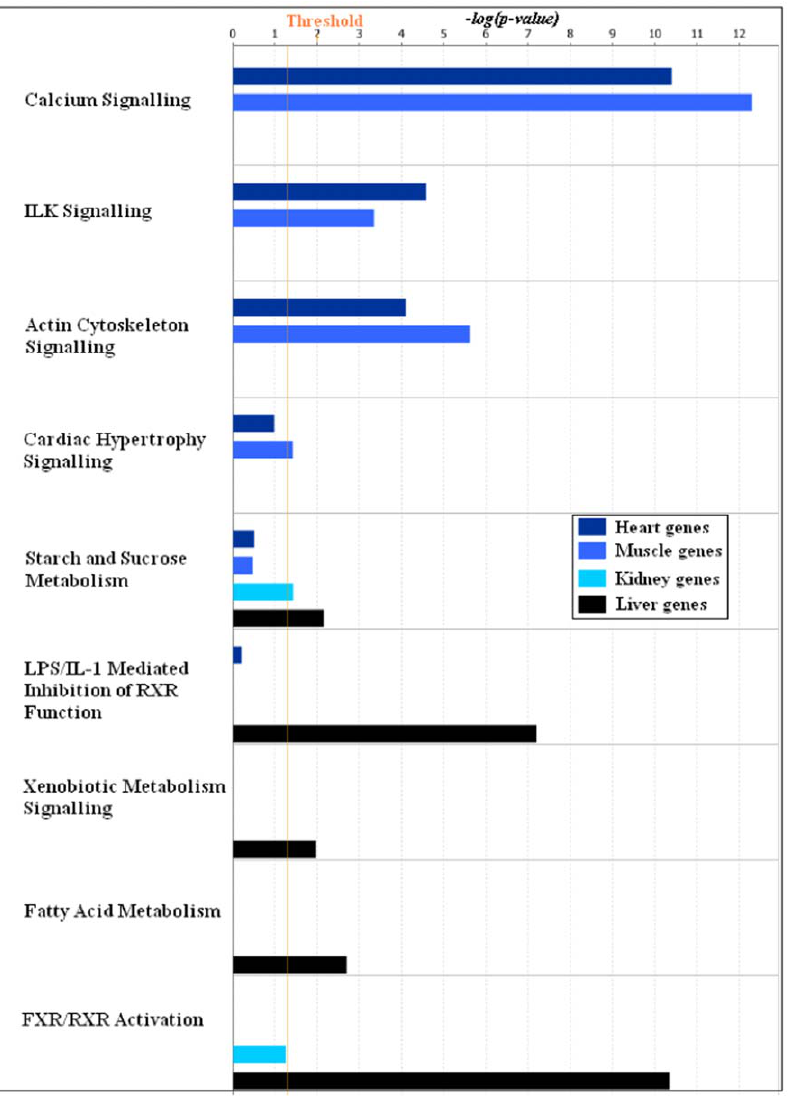
Figure 7. Enrichment of canonical pathways in the four tissue specific gene clusters. The top one hundred most influential probe-sets in the four tissue specific gene clusters obtained in the first factorization were subjected to signalling and metabolic pathways analysis in the IPA software. This graph shows the comparison of canonical pathways enriched in the four tissue specific gene clusters, heart 1 , muscle 1 , kidney 1 and liver 1 . The coloured bars show the significance of the enrichment for a particular pathway in the cluster computed by Fisher’s exact test.